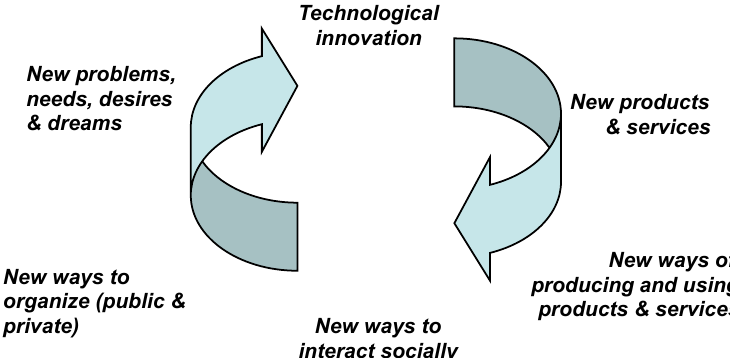
Fig. 1. Technological innovation self-reinforces via socio-economic